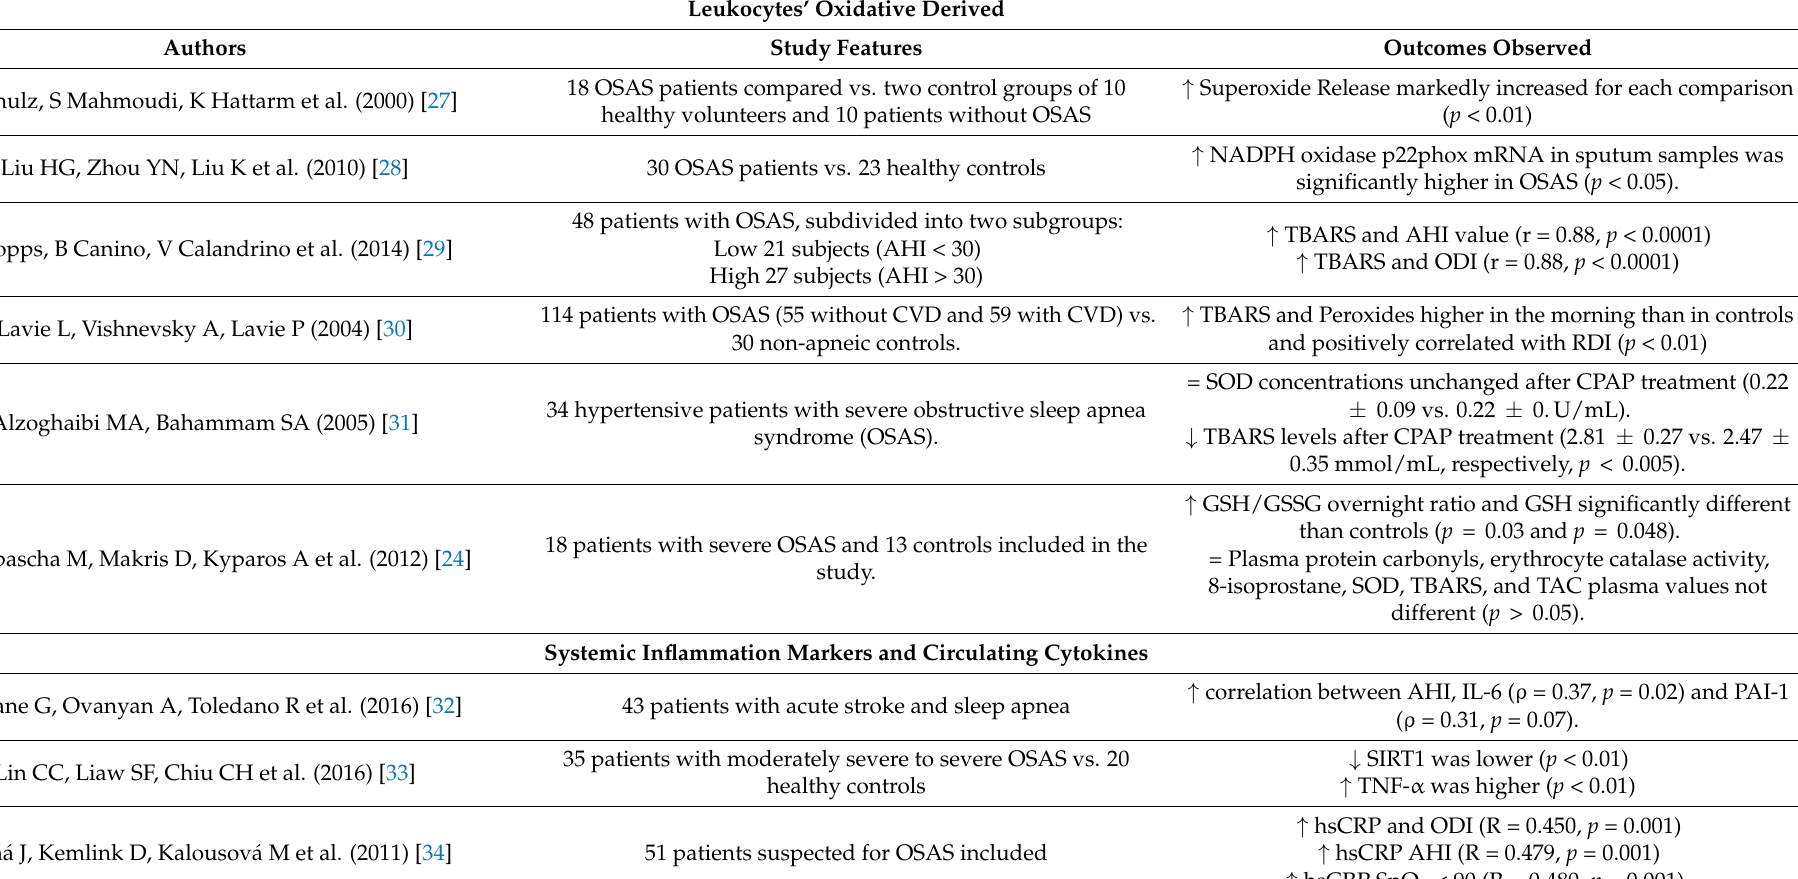
Table 2. Main biomarkers analysed in the literature divided by physiopathogenetic